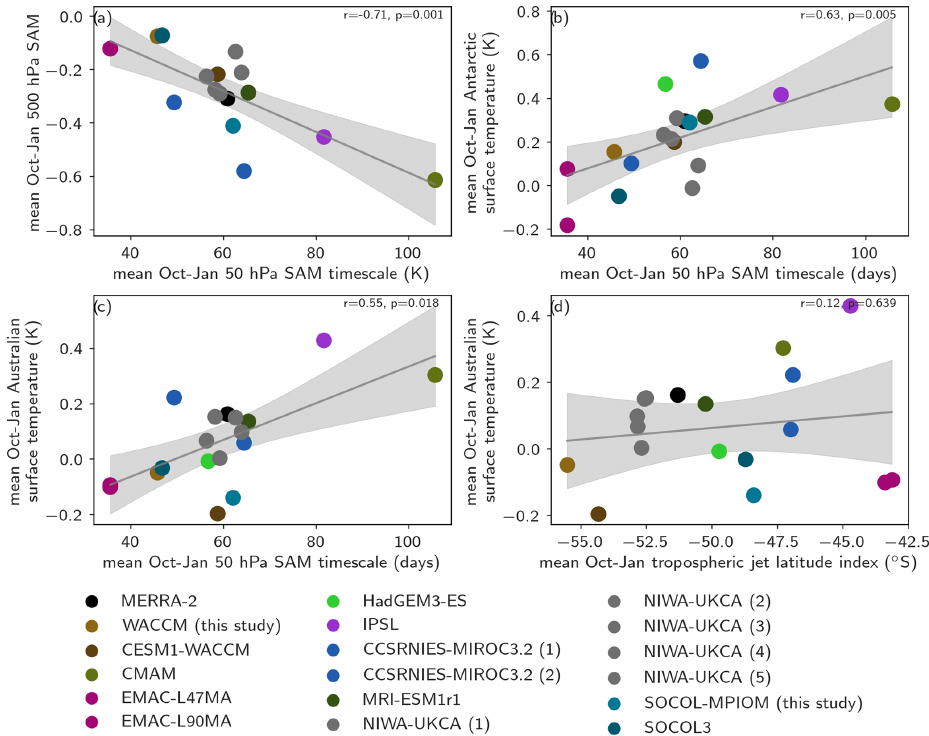
Figure A7. The mean October–January 50hPa SAM timescale in each model and the reanalysis data versus the mean October–January 500hPa SAM response (a) , Antarctic temperature anomalies (b) , Australian temperature anomalies (c) following weak polar vortex events, and the October–January mean tropospheric jet latitude index versus Australian temperature anomalies following weak polar vortex events (d) . The Spearman correlation coefficients and p values are annotated in the upper right corner for each relationship.